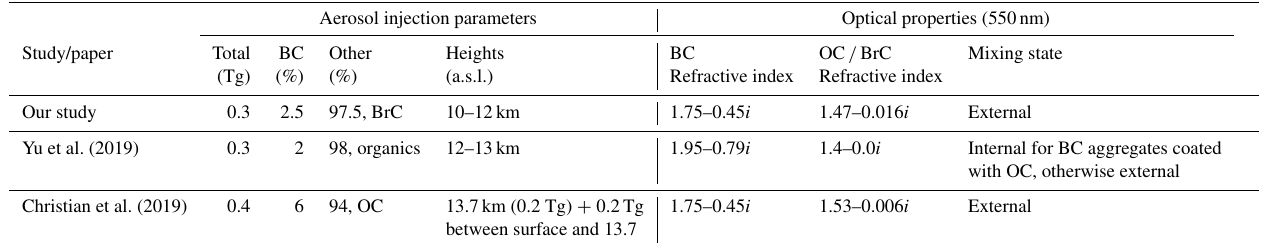
Table 2. Assumptions of injection parameters and optical properties for the pyroCb-emitted aerosols in different modeling studies. Aerosol injection parameters